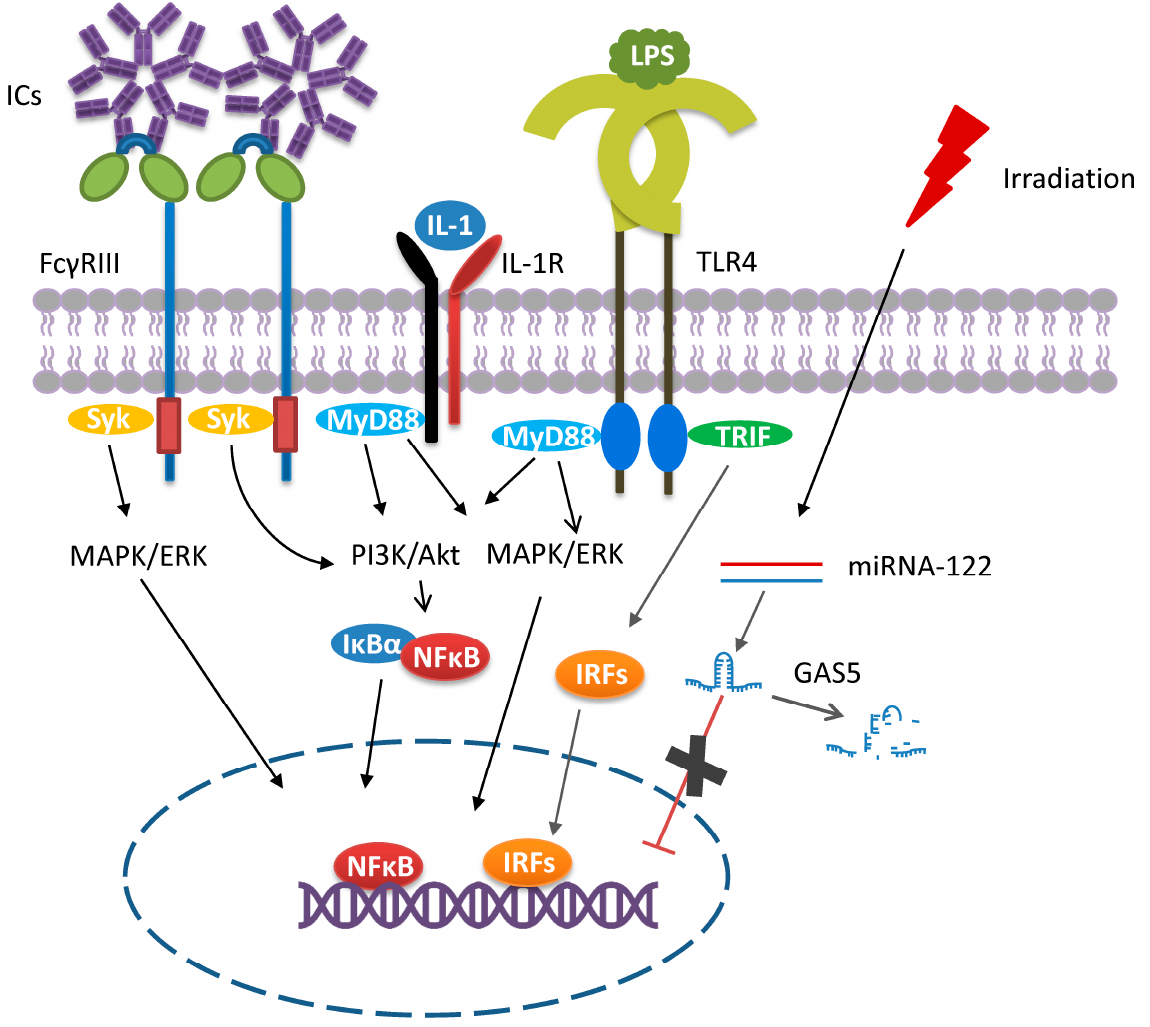
Figure 2. M2b polarization. The macrophage polarization toward the M2b phenotype needs two classical stimuli (ICs and LPS/IL-1). The crosslinking of Fc γ R by ICs triggers the activation of PI3K-, MAPK/ERK-, and NF- κ B-mediated signaling pathways. To fully polarize, the binding of LPS or IL-1 to their respective receptors is also required, which then induces the activation of NF κ B, PI3K/Akt, IRFs, and MAPKs. In addition, stimuli (e.g., irradiation, microRNA 122) other than the classical inducers have been described. The presence of long non-coding RNA GAS5 negatively correlates with M2b polarization. In response to irradiation exposure, the induced miRNA-122 expression leads to the degradation of GAS5, thereby favoring M2b